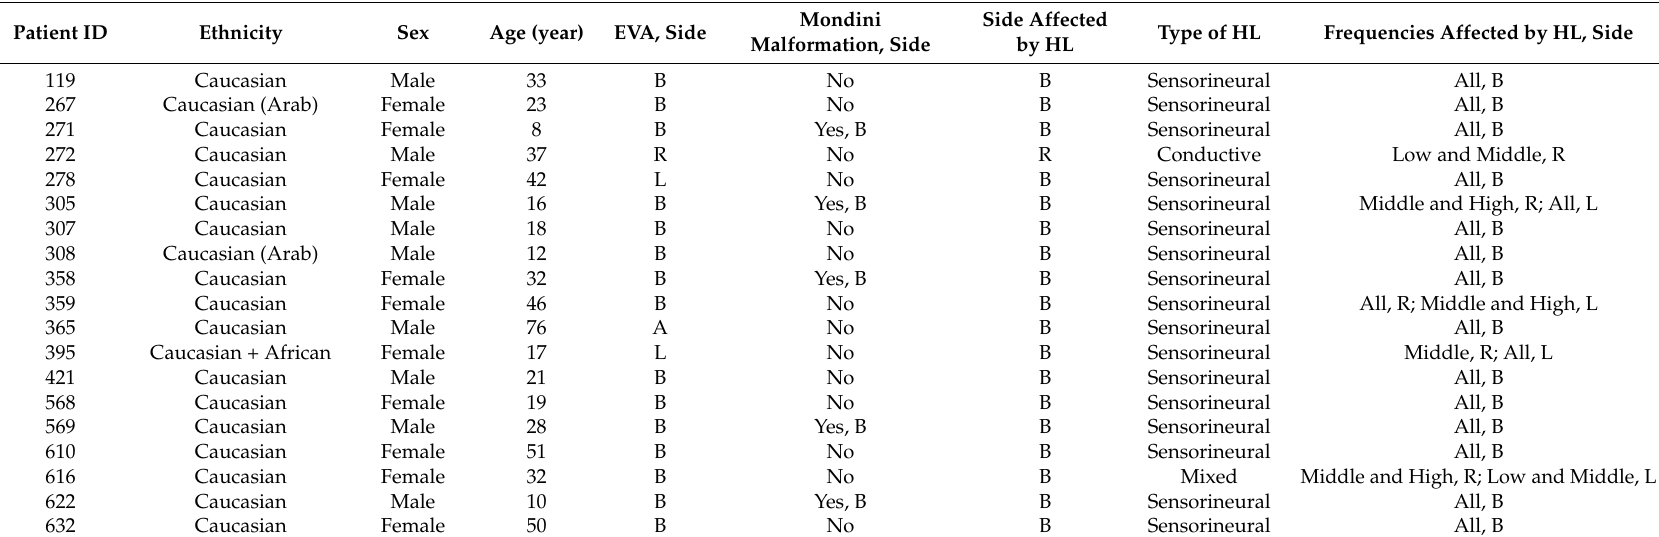
Table 1. Clinical signs of